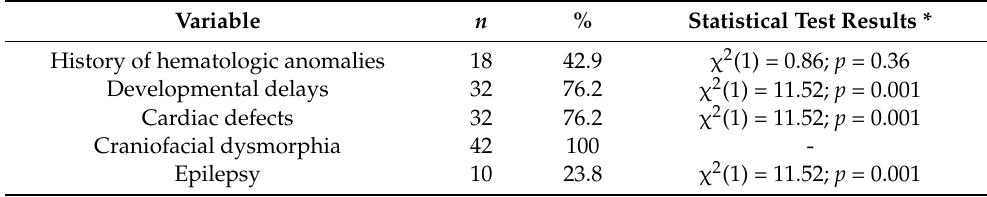
Table 4. Additional clinical parameters in the studied